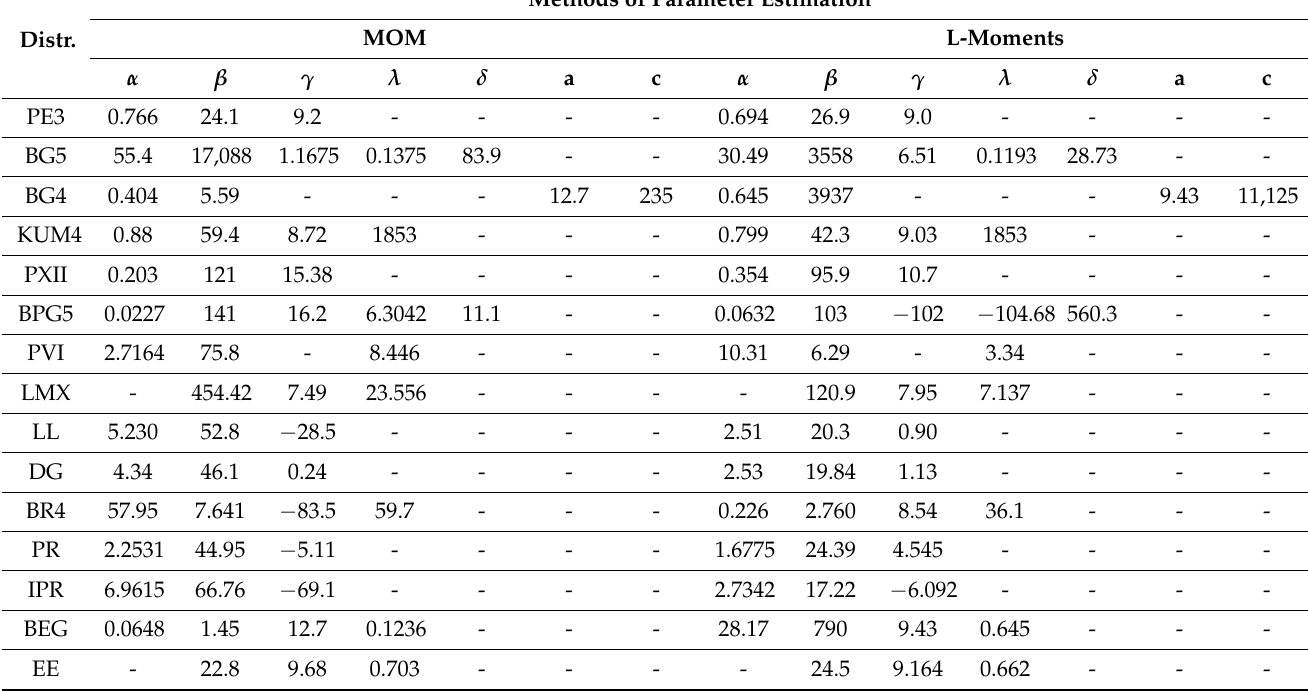
Table 7. Estimated parameter